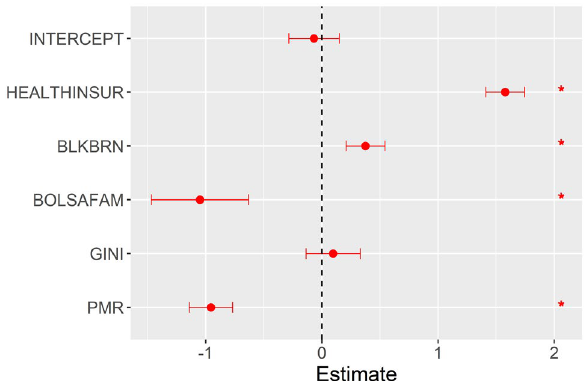
Figure 5. Results of the spatial–temporal ZINB regression models for the standardised mortality ratio of severe acute respiratory syndrome coronavirus 2.